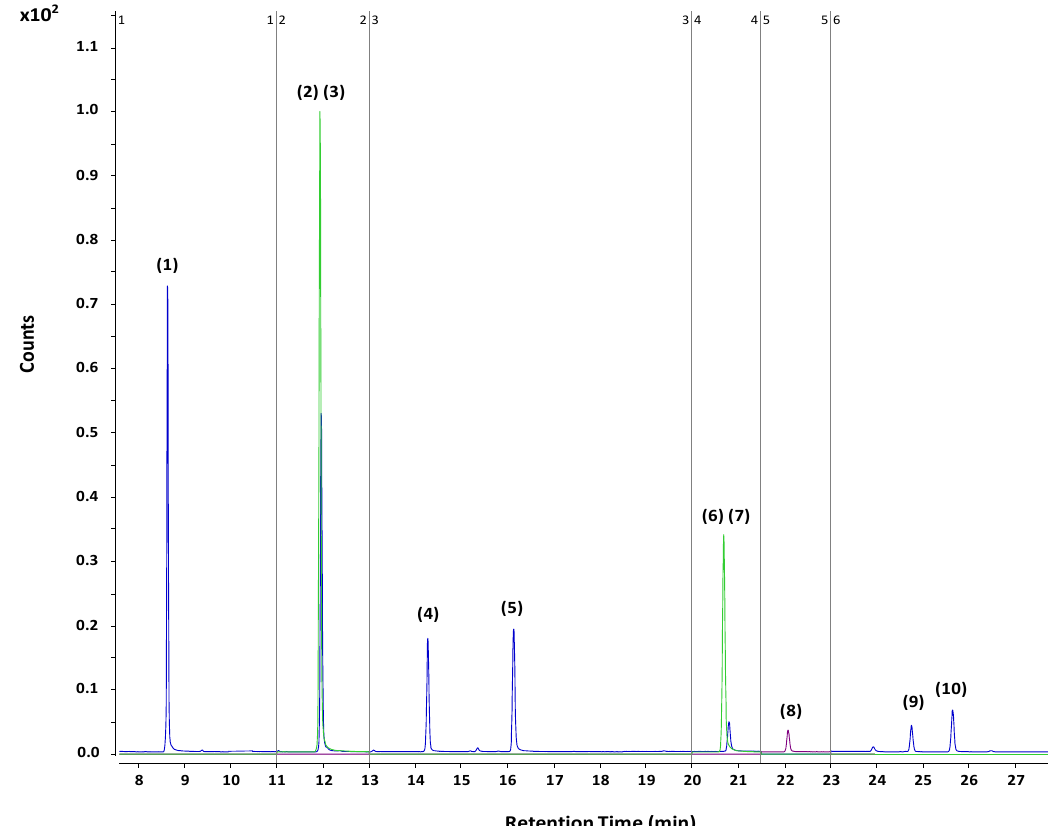
Figure 1. GC-Q-MS chromatogram obtained under SIM mode. Concentration of all the analytes: 75 µg L − 1 . Concentration of the ISs: 125 µg L − 1 . Peak identification: DPP ( 1 ), DBP-d 4 ( 2 ), DBP ( 3 ), DIPP ( 4 ), DNPP ( 5 ), DHP-d 4 ( 6 ), BBP ( 7 ), DEHA ( 8 ), DCHP ( 9 ), and DEHP ( 10 ).